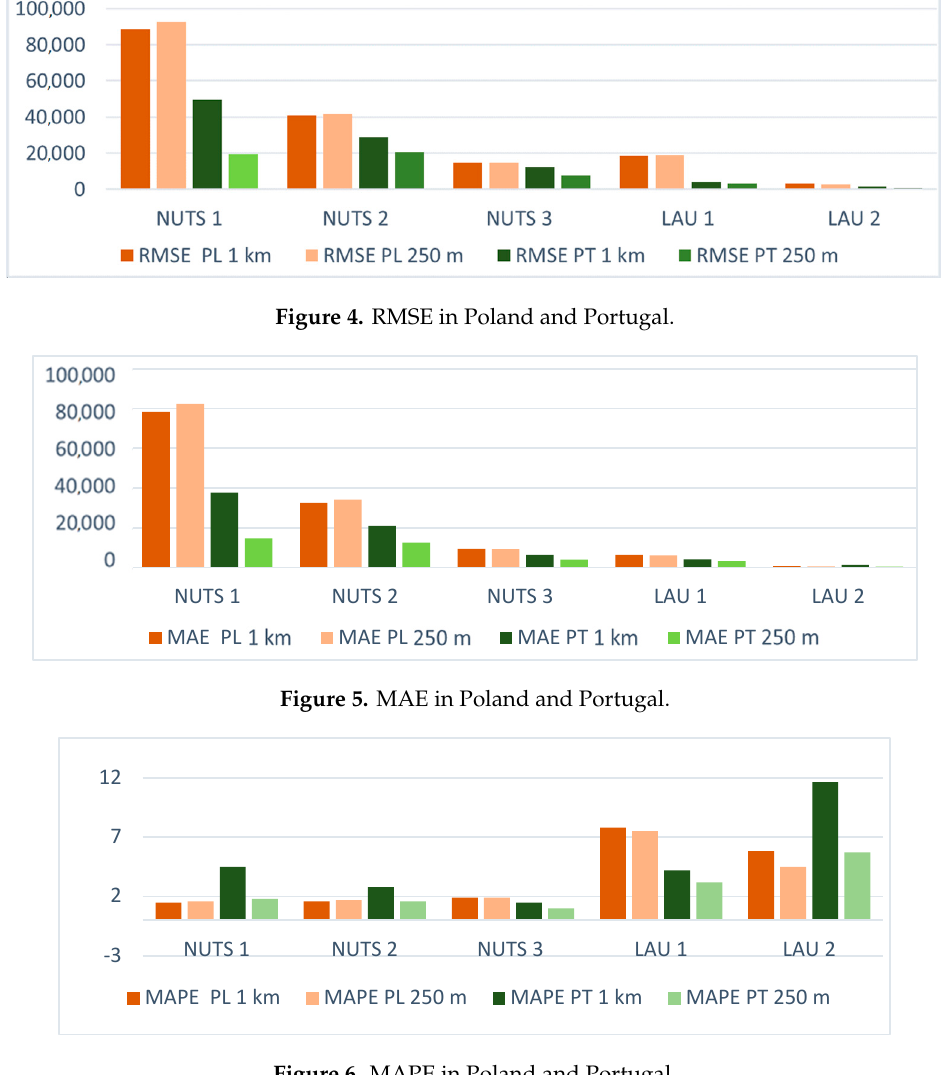
Figure 6. MAPE in Poland and Portugal.